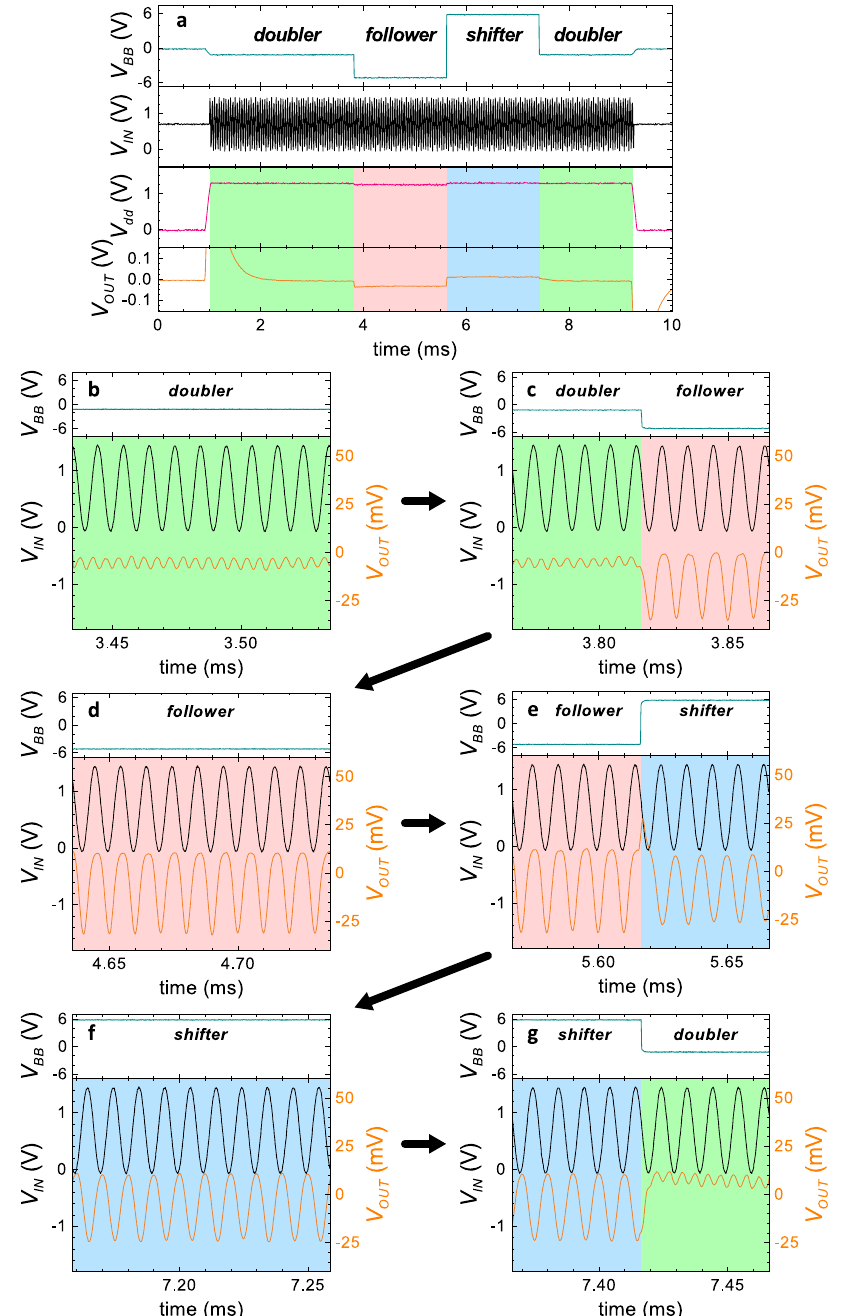
Fig. 5 | Embedded 3-to-1 signal modulation measured with the same setup and BB-RFET shown in Fig. 3b. A single device can be dynamically recon fi gured between follower (red shade), phase shifter (blue shade) and frequency doubler (green shade) by the applied voltage at the back-gate V BB . a Large-scale overview of the applied and measured voltages for the complete recon fi guration sequence